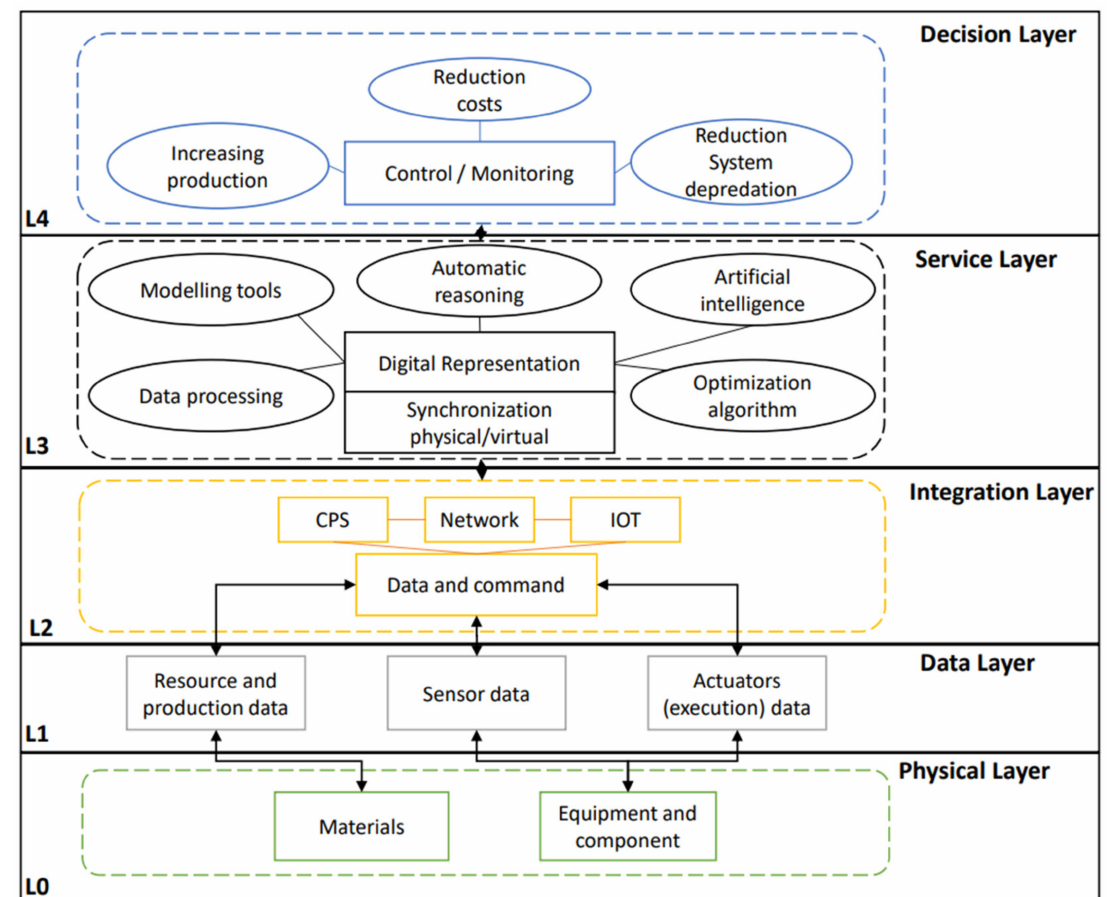
Figure 1. The architecture supporting the